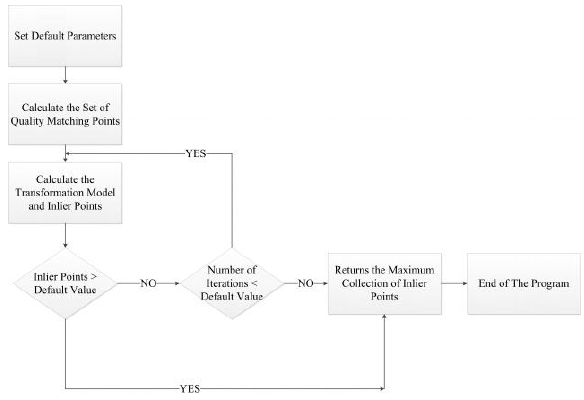
Figure 2. PROSAC algorithm